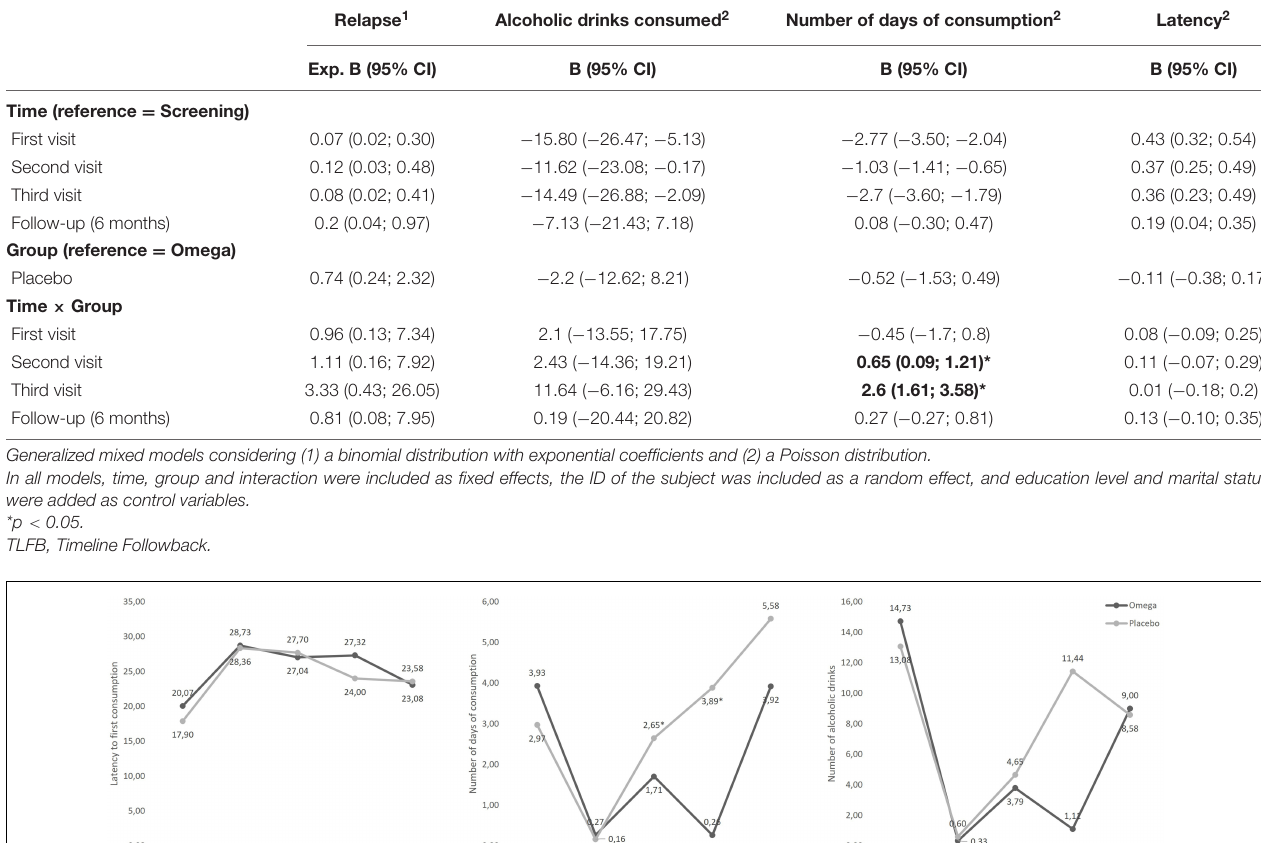
TABLE 3 | Non-standardized regression coefficients (followed by 95% confidence intervals) of the mixed models predicting outcomes related to alcohol consumption measured by the